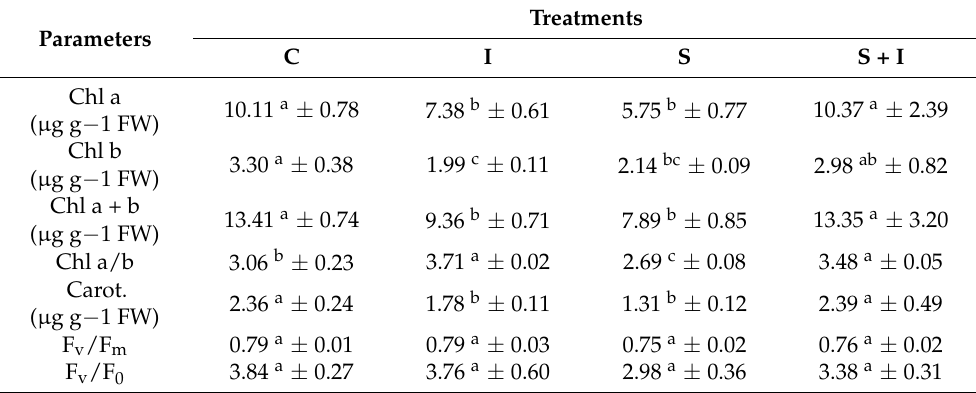
Table 2. Solanum melongena L. leaves photosynthetic pigments as affected by 200 mM NaCl (S) and/or inoculum (I) treatments.